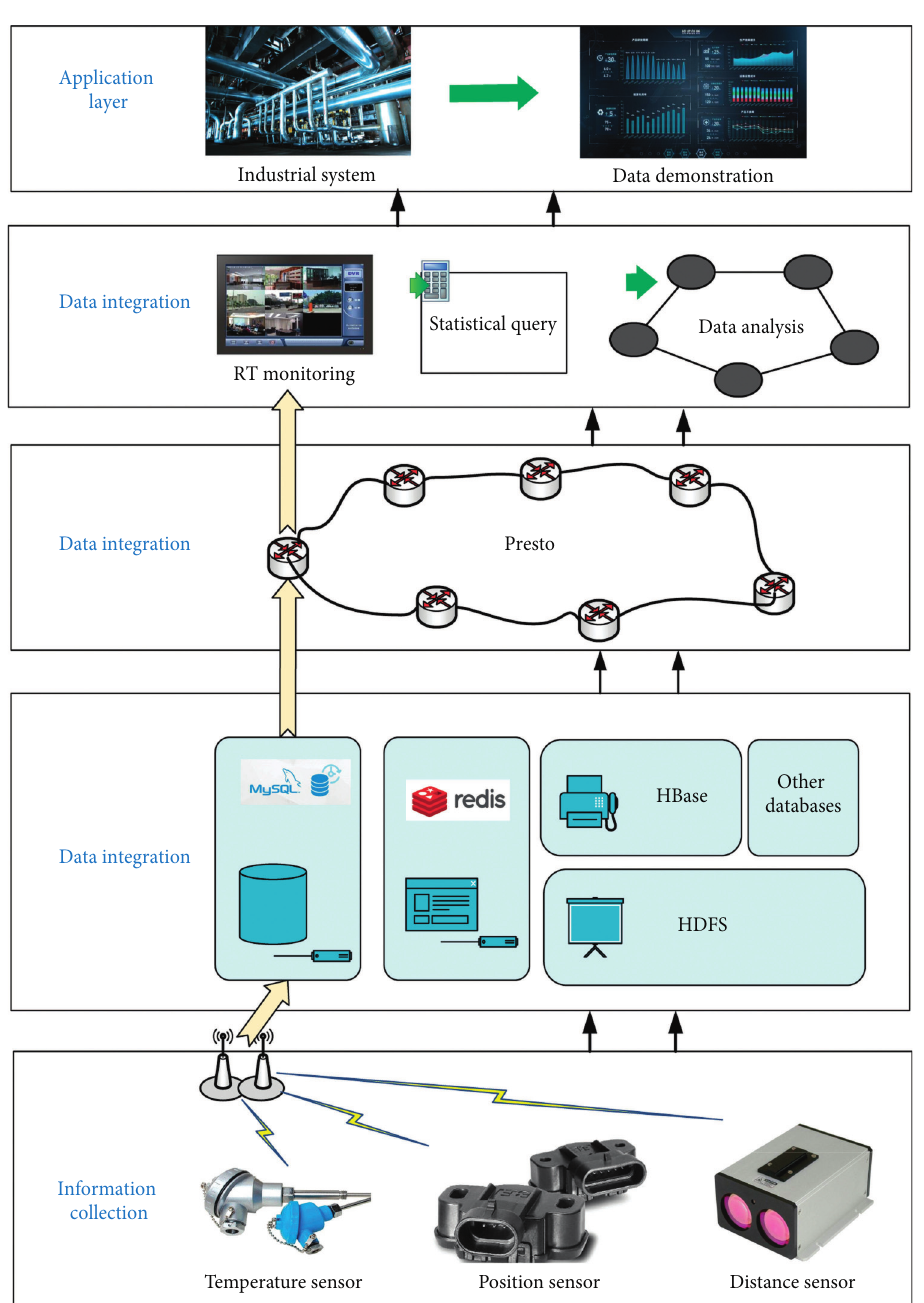
Figure 2: Architecture of the industrial heritage cloud